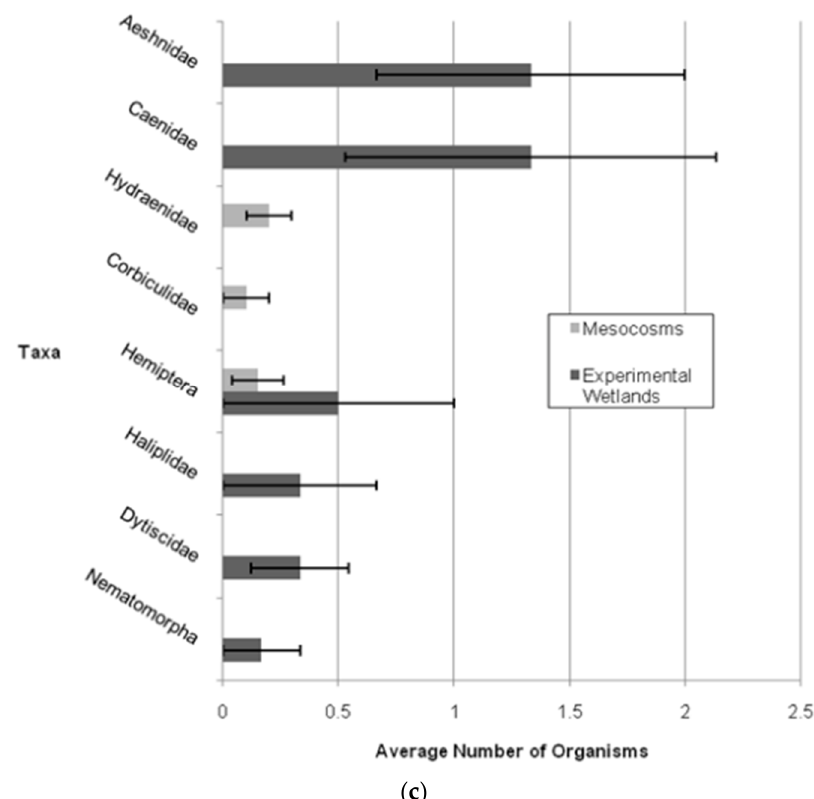
Figure 7. Average number of organisms by taxa in Hester–Dendy samples from the experimental wetlands and the mesocosms in 2008 (mesocosm sample size adjusted to reflect differences in surface area between traps used in the mesocosms and those used in the experimental wetlands). ( a ) High frequency taxa; ( b ) middle frequency taxa, ( c ) low frequency taxa. Table 9. The number of taxa found in samples by sample type and sample